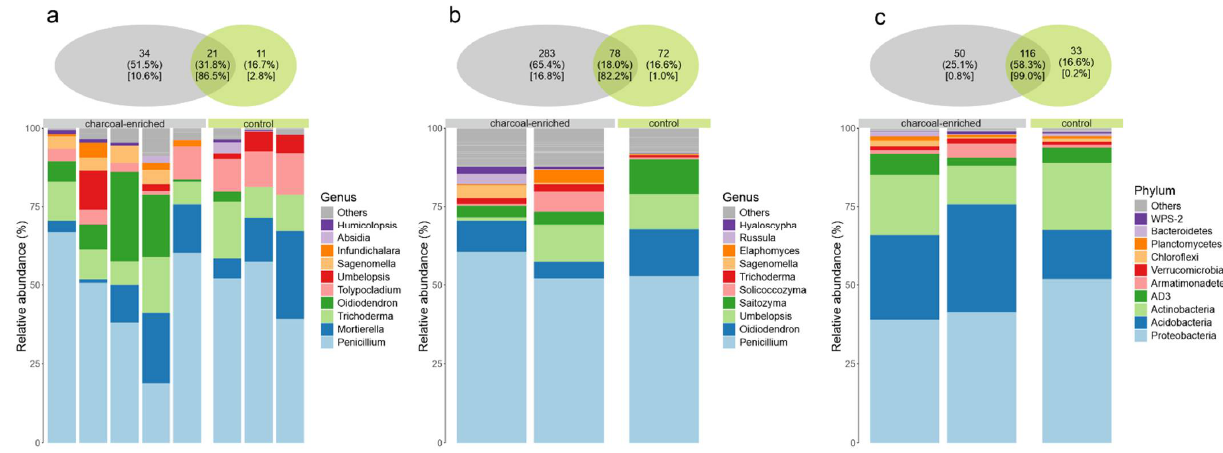
Figure 6. Relative abundance of 10 most common fungal genera ( a ), ITS metabarcoding ( b ) and 10 most common bacterial phyla in 16S metabarcoding ( c ). The Venn diagrams above the bar charts indicate fungal species and bacterial genera unique to and shared between charcoal-enriched and control samples, starting from the top: numbers of species/genera in each group, proportions of the overall number of species/genera in each group (in round brackets), and proportions of colony forming units or ITS/16S sequences belonging to species/genera in each group (in square brackets). Please note the higher diversity of fungi in charcoal-enriched samples (high number/proportion of unique species, more diverse composition of most common genera) and lack of such a clear effect for bacteria.